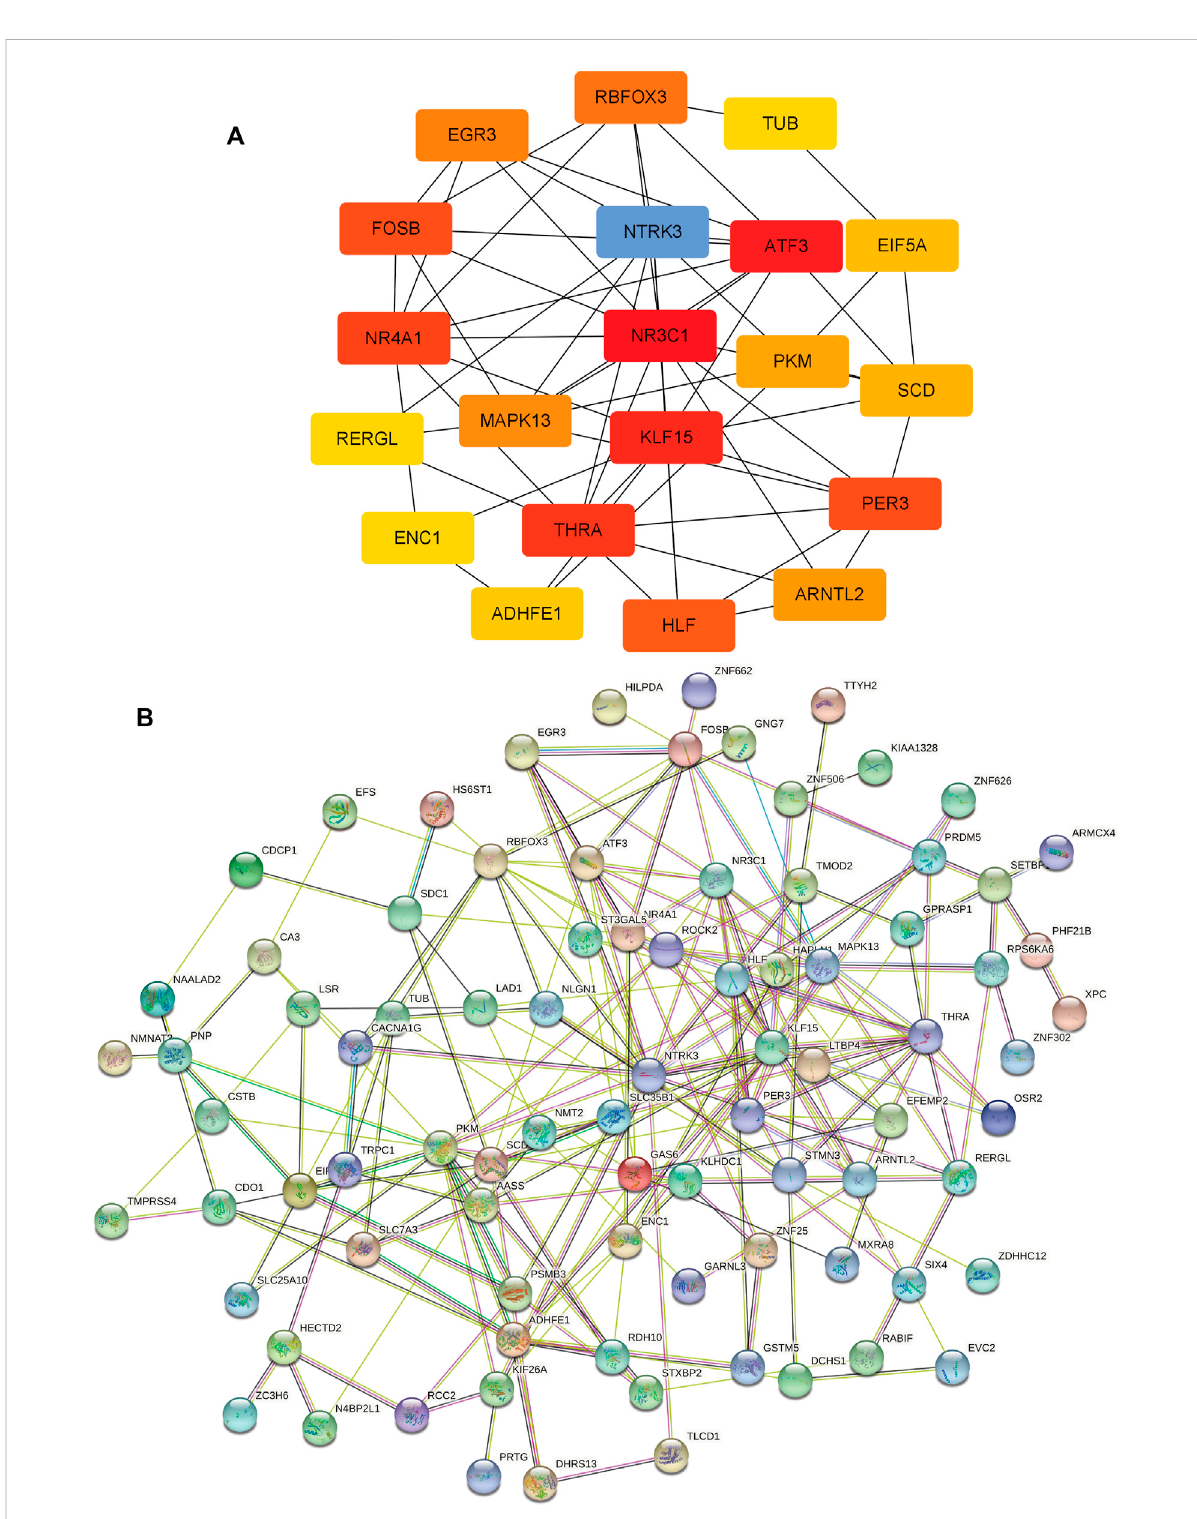
FIGURE 5 Protein-protein interaction(PPI)network andhub Genes. (A) 20hub geneswith thegreatestMaximalClique Centrality (MCC) value, Thedarker the color, the higher the MCC value. (B) PPI network of 95 overlapping